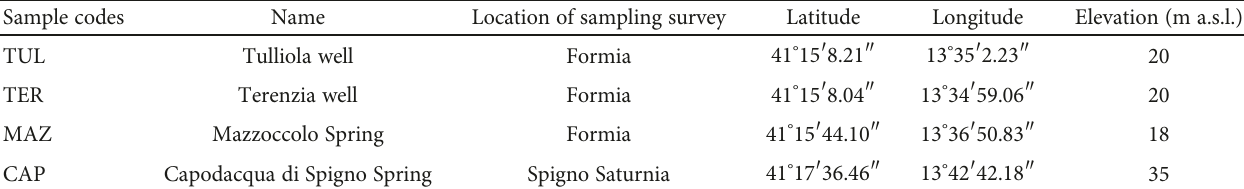
Table 1: The location of the spring and the well water sampling survey. Sample